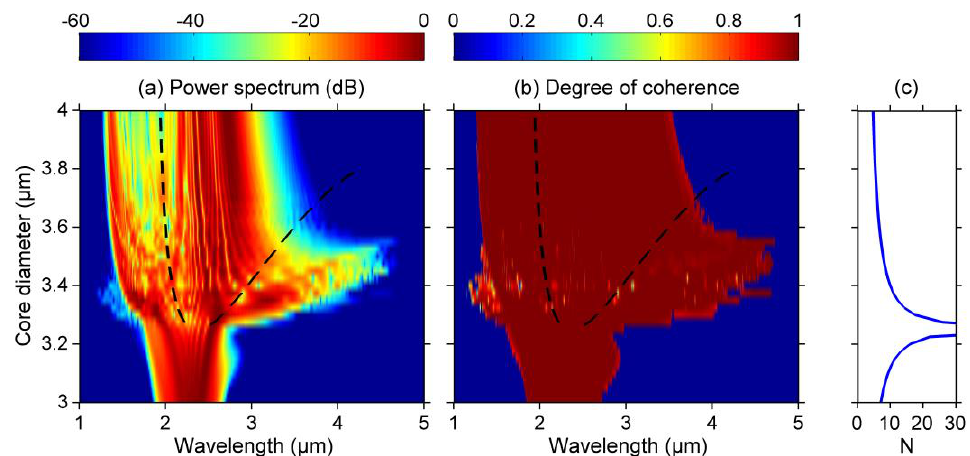
Figure 7. ( a ) Evolution of the average SC spectrum. The fiber length was fixed to 12 cm, and the input peak power of 200-fs pulses at 2300 nm was set to 1 kW (equivalent to 200-pJ pulse energy). ( b ) Corresponding evolution of the modulus of the complex degree of first-order coherence. ( c ) Corresponding soliton number calculated at pump wavelength.